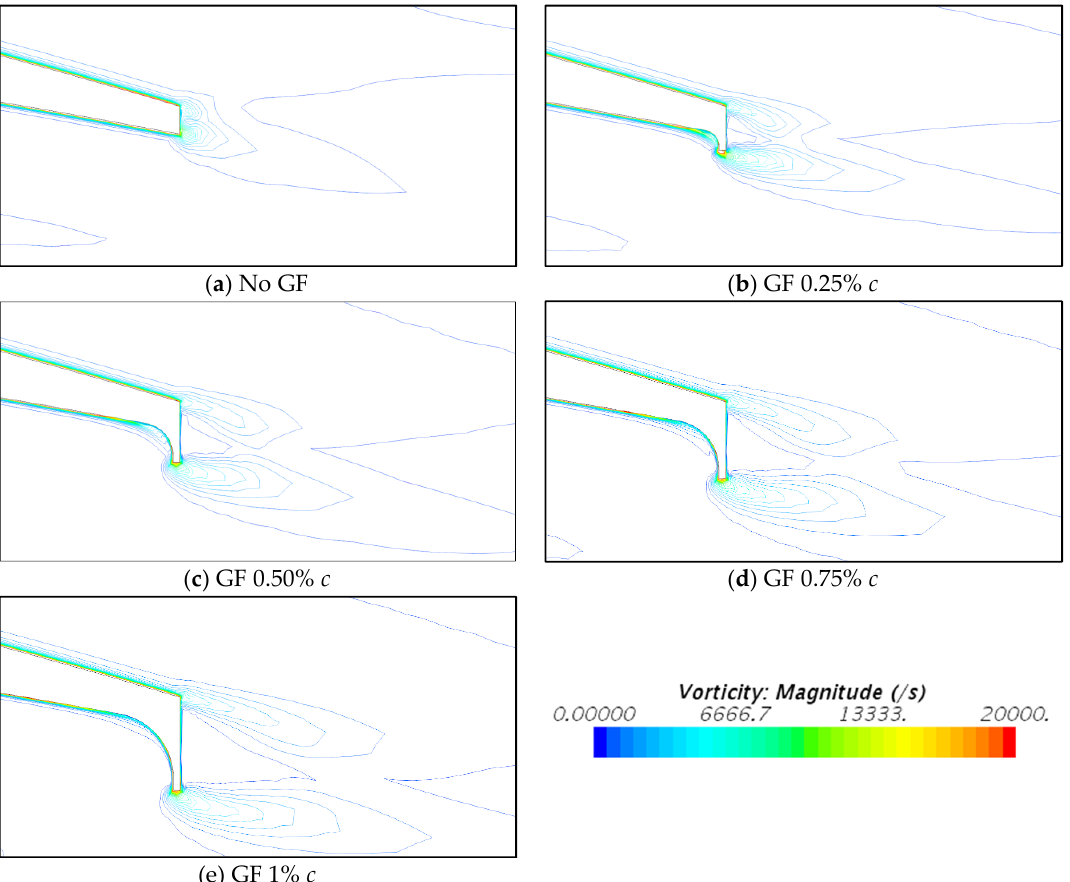
Figure 5. Streamwise vorticity fields for the case without GF and GF lengths of 0.25% c , 0.50% c , 0.75% c and 1% c at an angle of attack α = 0 °